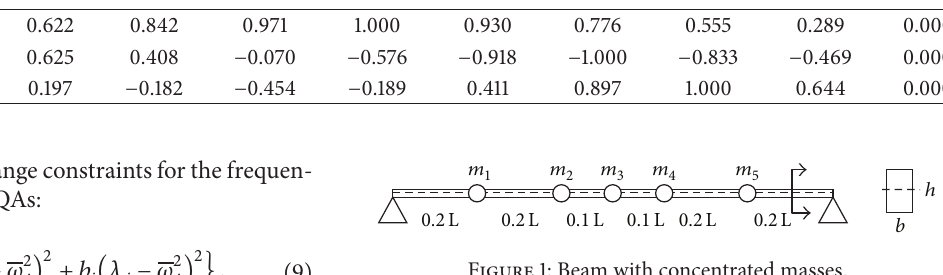
Table 2: Target mode shapes (Case 1).